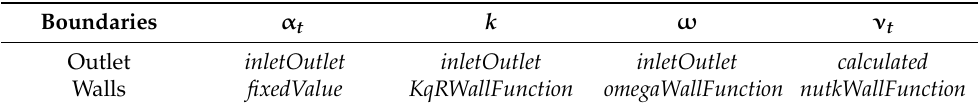
Table 6. Boundary conditions for the variables of the turbulent model. Boundaries